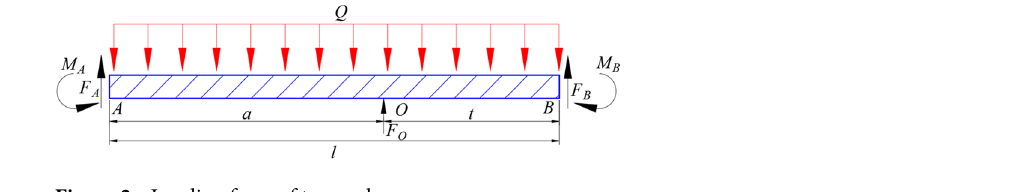
Figure 2. Loading form of top coal.